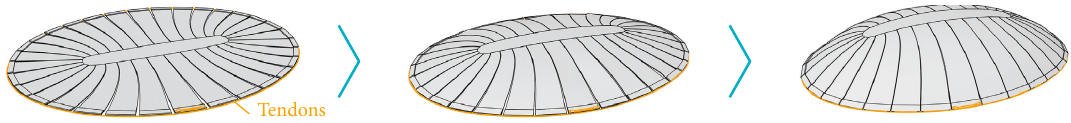
Figure 1: Construction principle of the Pneumatic Forming of Hardened Concrete (PFHC) construction method.